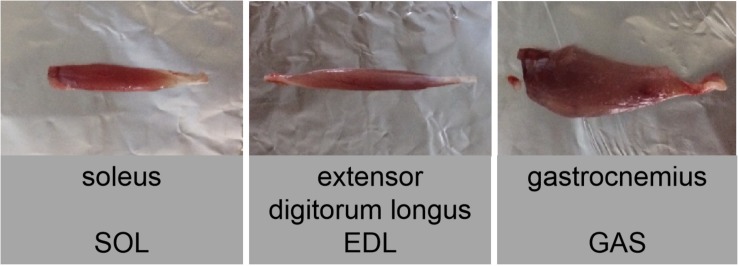
Images of skeletal muscles of Daurian ground squirrels.